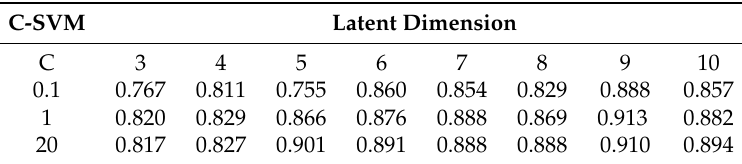
Table 5. Results of SVM classification on latent